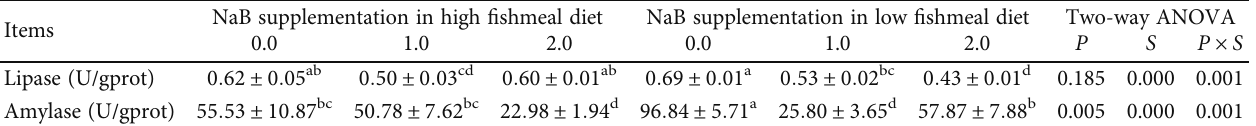
Table 5: E ff ect of dietary sodium butyrate on digestive enzyme activities in foregut of rainbow trout. NaB supplementation in high fi shmeal diet NaB supplementation in low fi shmeal diet Two-way ANOVA Items